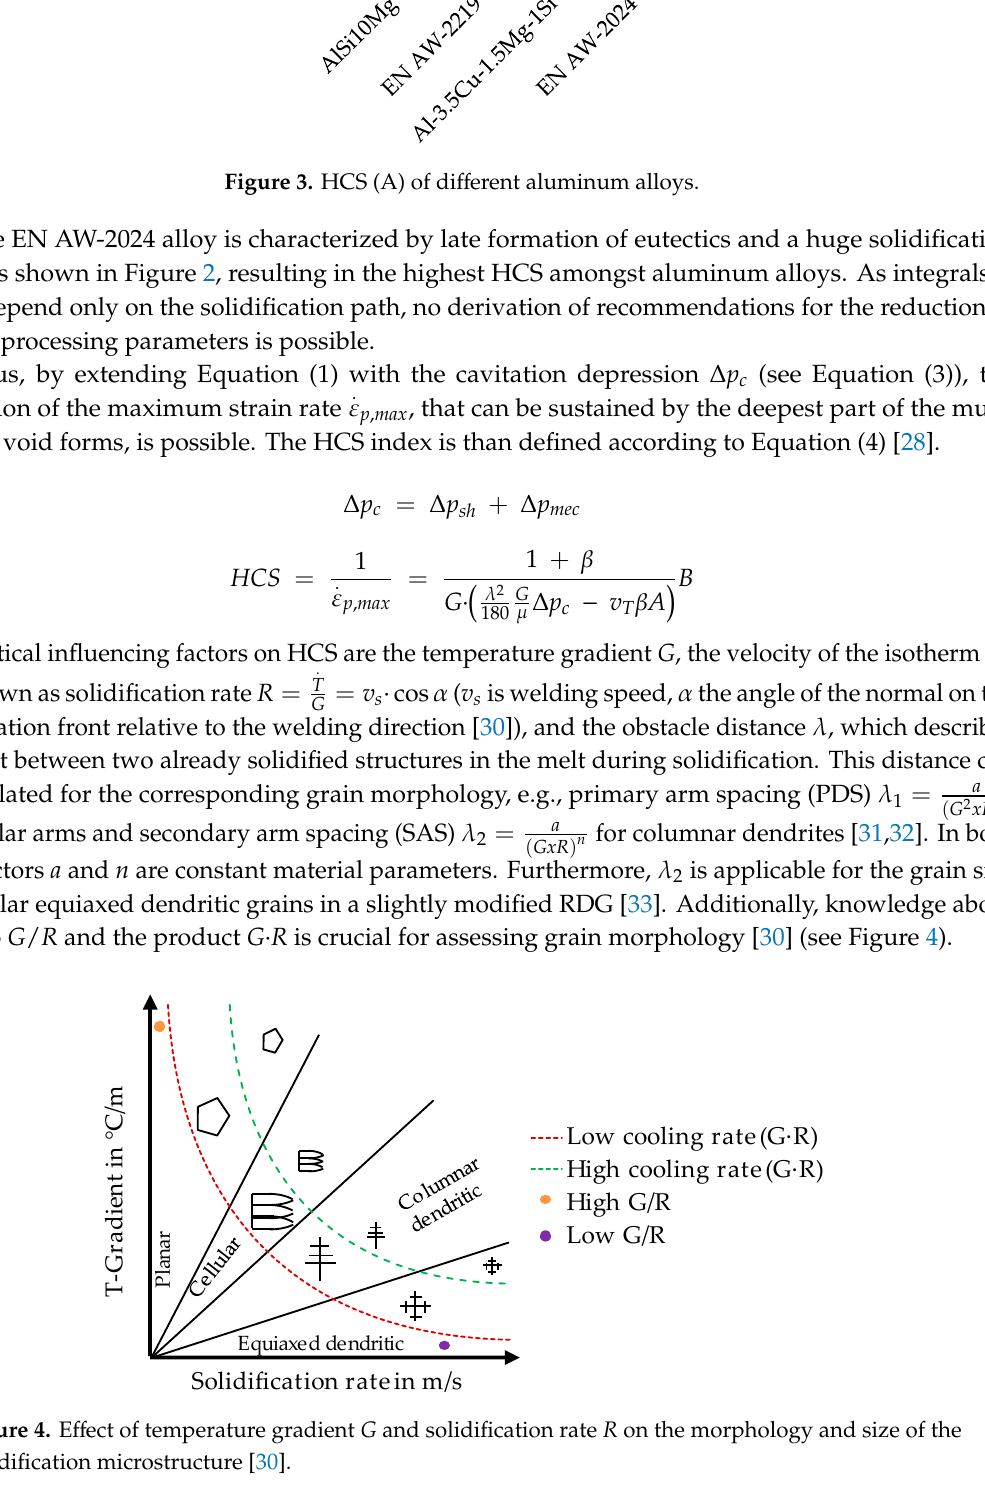
Figure 4. E ff ect of temperature gradient G and solidification rate R on the morphology and size of the Figure 4. Effect of temperature gradient 𝐺 and solidification rate 𝑅 on the morphology and size of solidification microstructure the solidification microstructure [30].